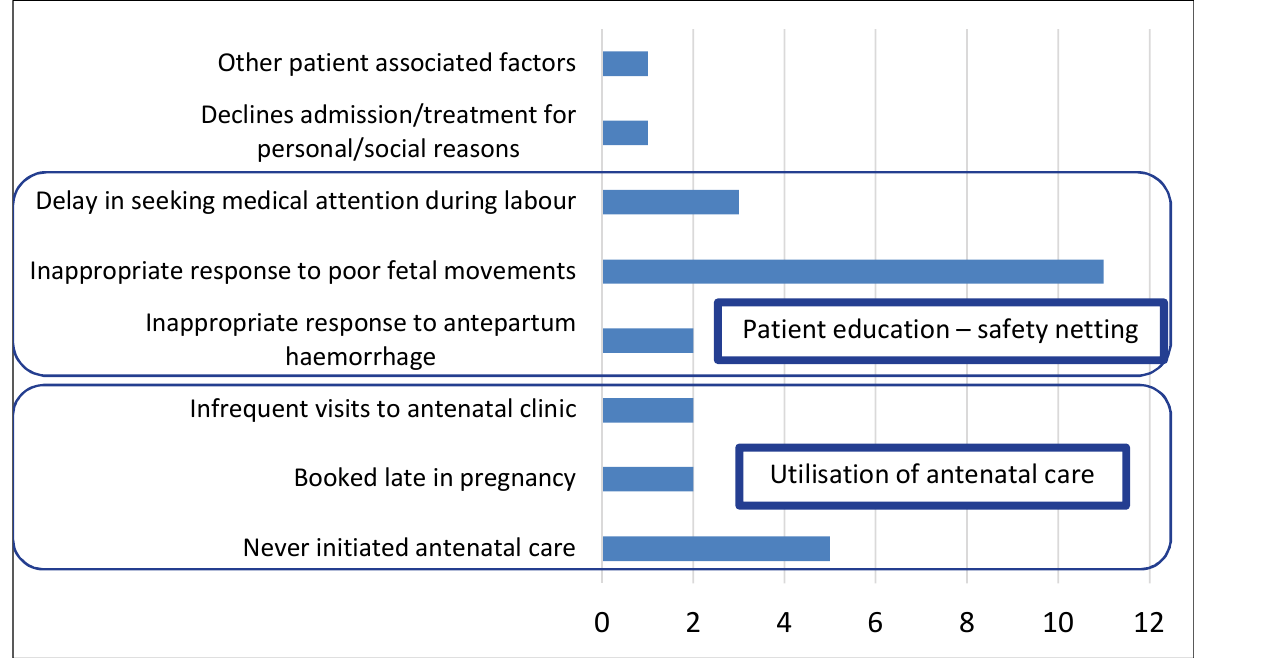
Figure 2: Time frame for the inpatient management of SAM